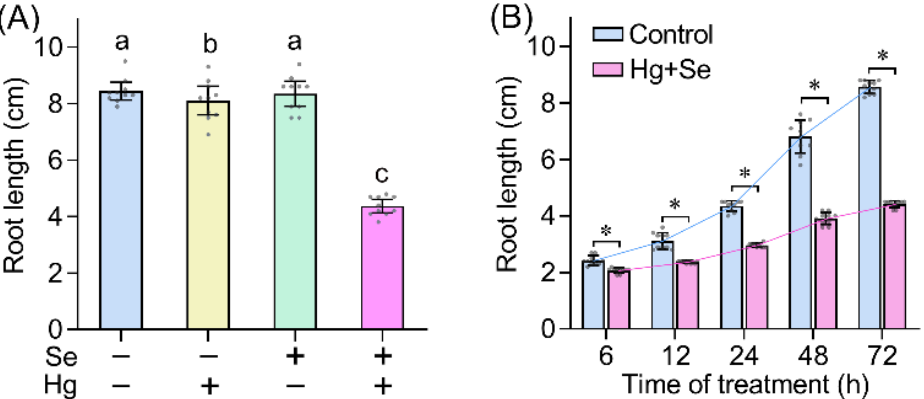
Figure 1. Hg + Se inhibited root growth of B. rapa seedlings. ( A ) The effect of Se, Hg, or Se + Hg on root length. Different lowercase letters indicated significant difference among different treatments (one-way analysis of variance, ANOVA; n = 10; p < 0.05). ( B ) Time-course monitoring of root length upon Se + Hg treatment. Asterisk indicated significant difference between control and Se + Hg (ANOVA; n = 10; p < 0.05).